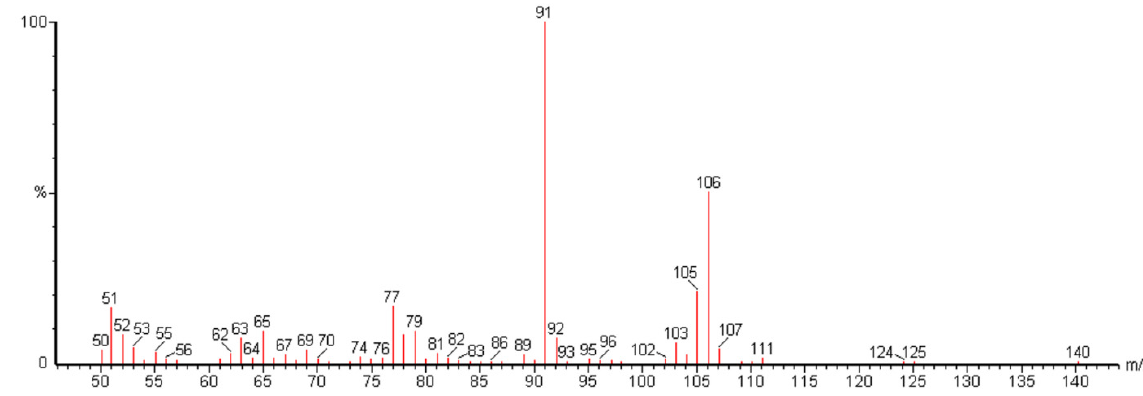
Figure 7. MS spectrum for the peak with a retention time of 13.04 min.